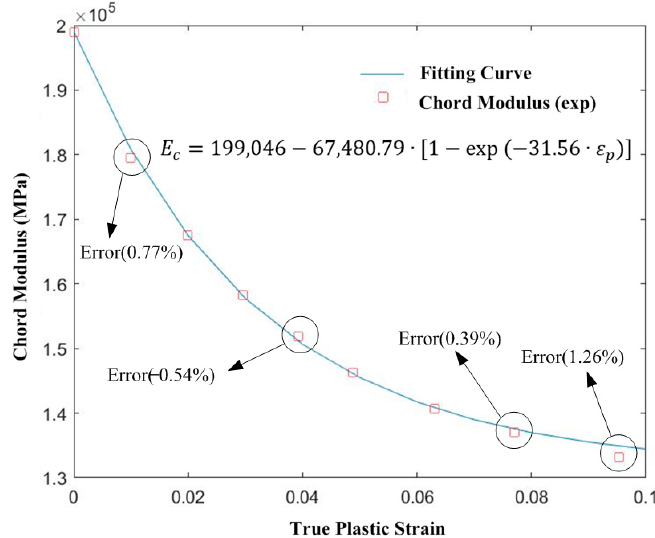
Figure 4. Fitting of the chord modulus mathematical model.